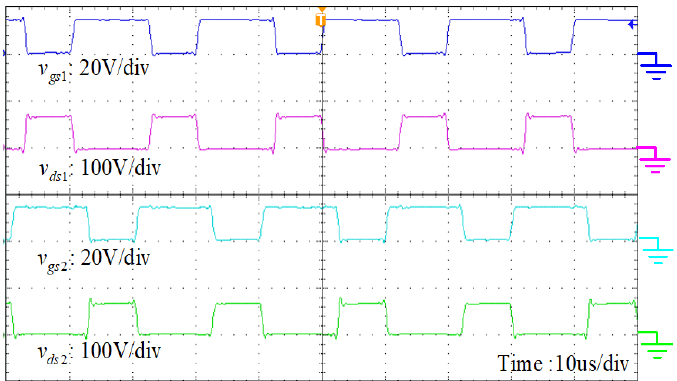
Figure 8. Measured waveforms of the gating signals and the input and output voltages.